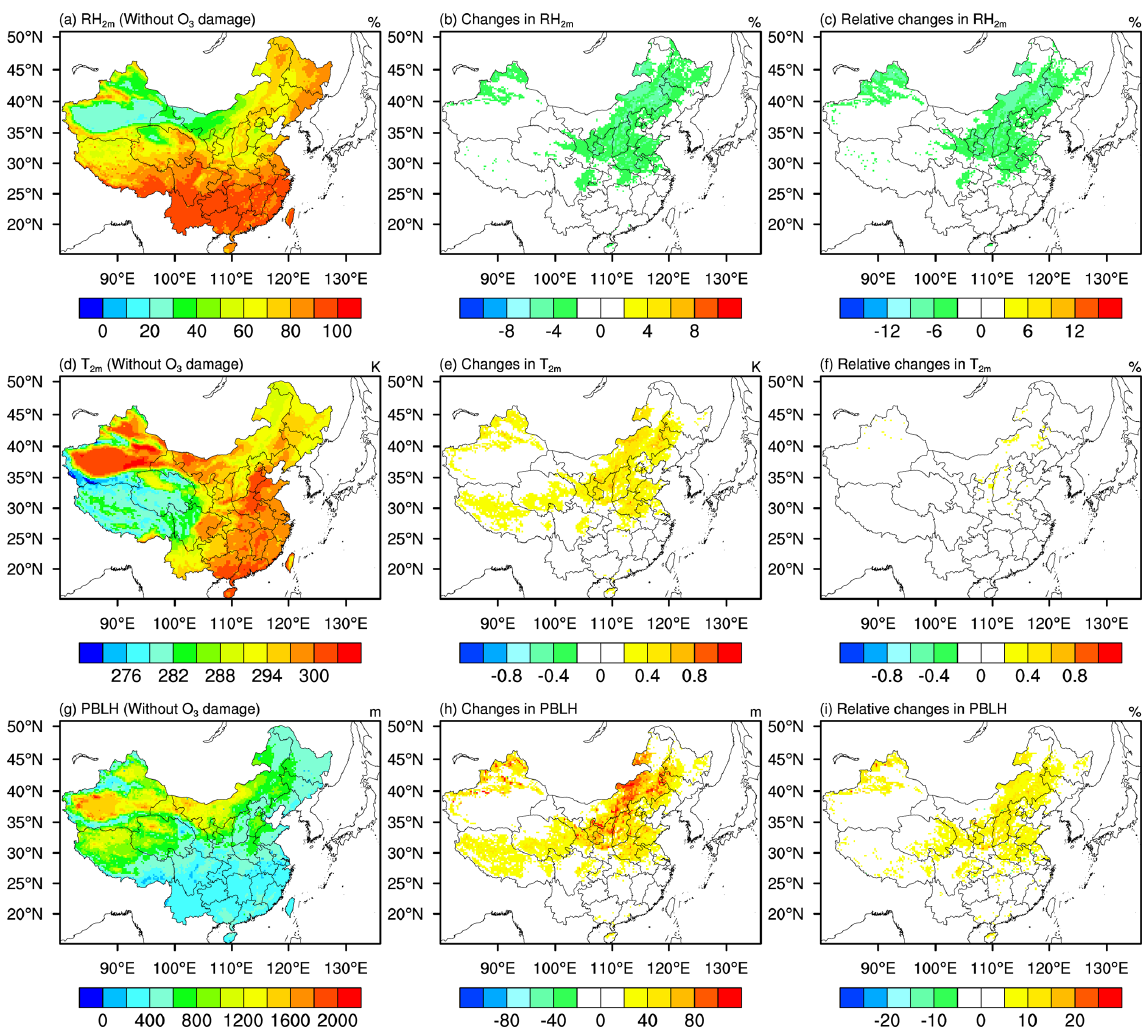
Figure 7. Spatial distribution of mean (a) 2m relative humidity, (d) 2m temperature, and (g) planetary boundary-layer height (PBLH) in JJA of 2014–2017 from the simu_withoutO 3 experiment; absolute changes in (b) RH 2m , (e) T 2m , and (h) PBLH caused by O 3 damage; and relative changes in (c) RH 2m , (f) T 2m , and (i) PBLH caused by O 3 damage. Absolute changes are the results from simu_withO 3 minus results from simu_withoutO 3 . Relative changes are calculated by absolute changes over the results from simu_withoutO 3 .